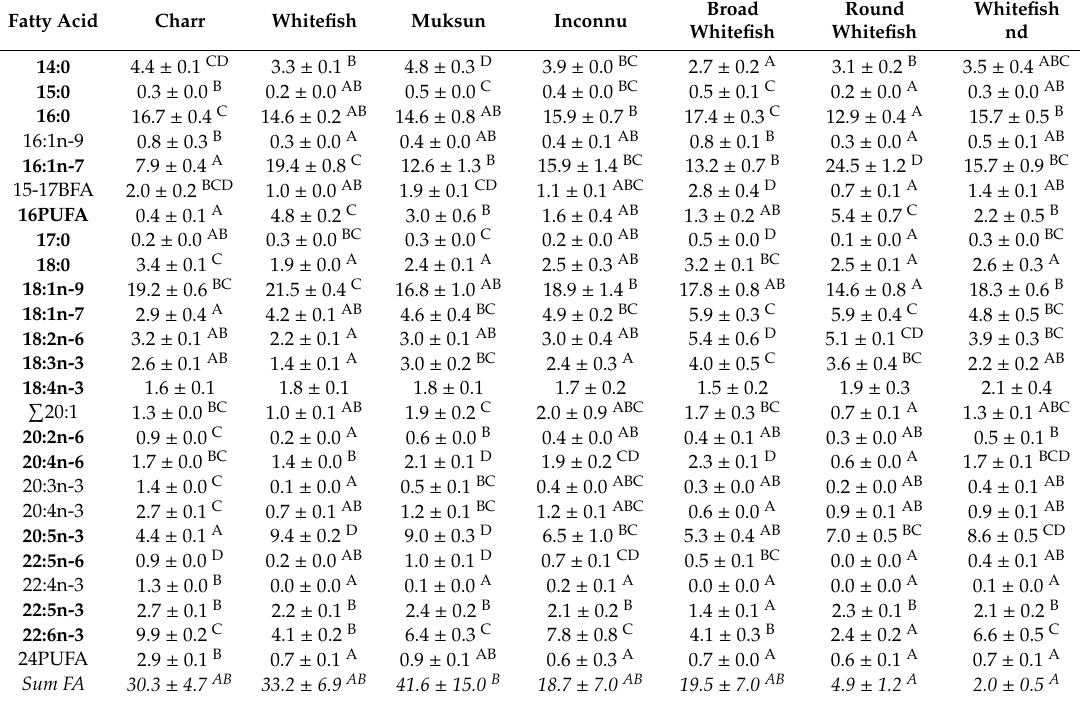
Table 5. Mean levels of fatty acids (% of the total) and total content of fatty acids (Sum FA, mg g − 1 wet weight) in triacylglycerols of Salmoniformes species: charr— S. drjagini from Sobachye Lake; whitefish— C. lavaretus from Sobachye Lake; muksun— C. muksun from Pyasino Lake; inconnu— S. leucichthys nelma from Pyasino Lake; broad whitefish— C. nasus from Pyasino Lake; round whitefish— P. cylindraceum from Sobachye Lake; whitefish nd—the non-identified form of C. lavaretus from Sobachye Lake. Cases (fatty acids) with normal distribution are given in bold. Means labeled with the same letter are not significantly di ff erent at P < 0.05 after ANOVA post hoc Tukey HSD test (cases with normal distribution) or Kruskal–Wallis test. If ANOVA is insignificant, letters are